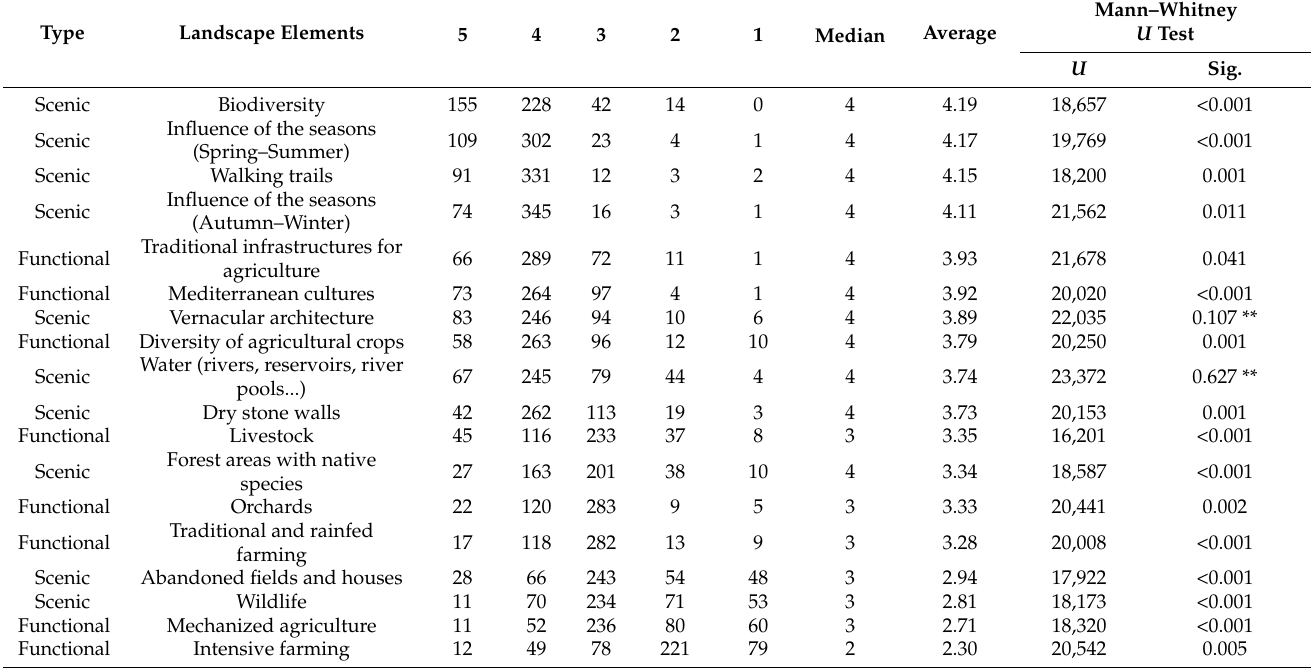
Table 4. Landscape element